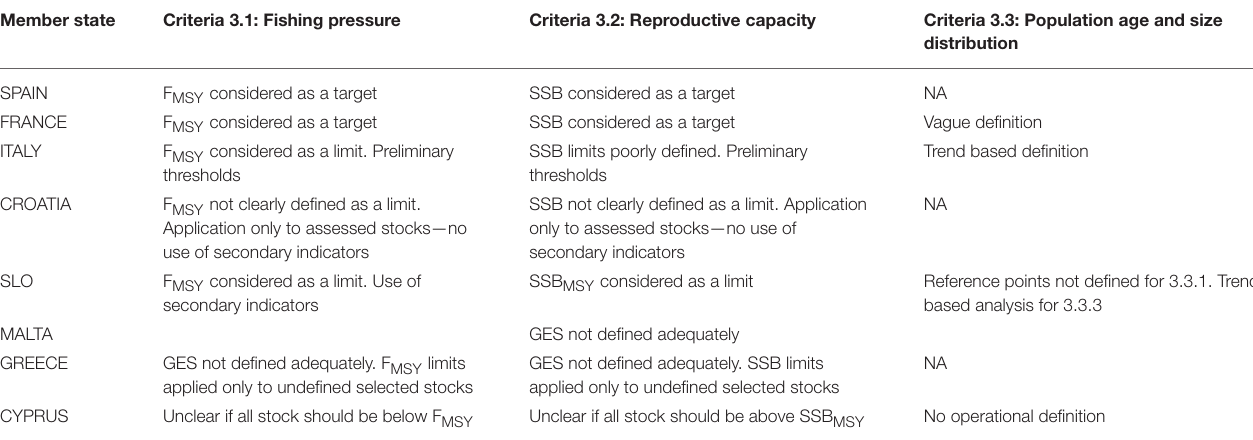
TABLE 4 | Main elements of discrepancies arising from the comparison between member states GES definition according to Descriptor 3 criteria in respect to MSFD criteria definition ( EU-COM, 2010). Member